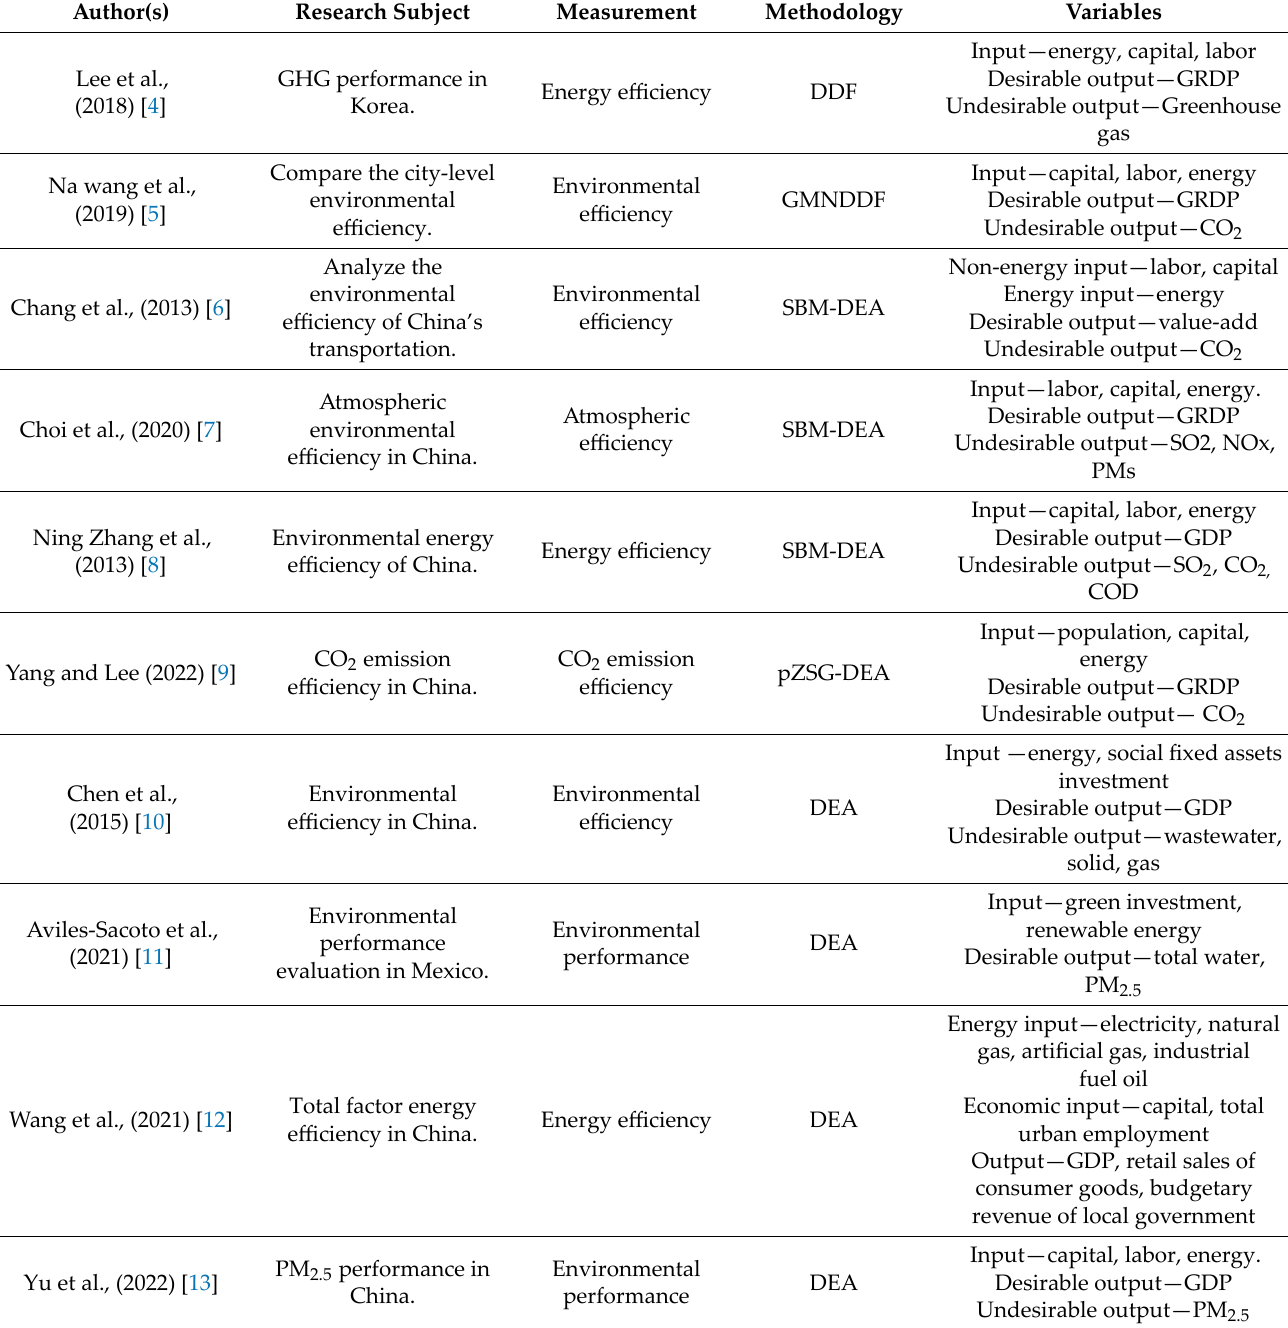
Table 1. Literatures Comparison for the model and